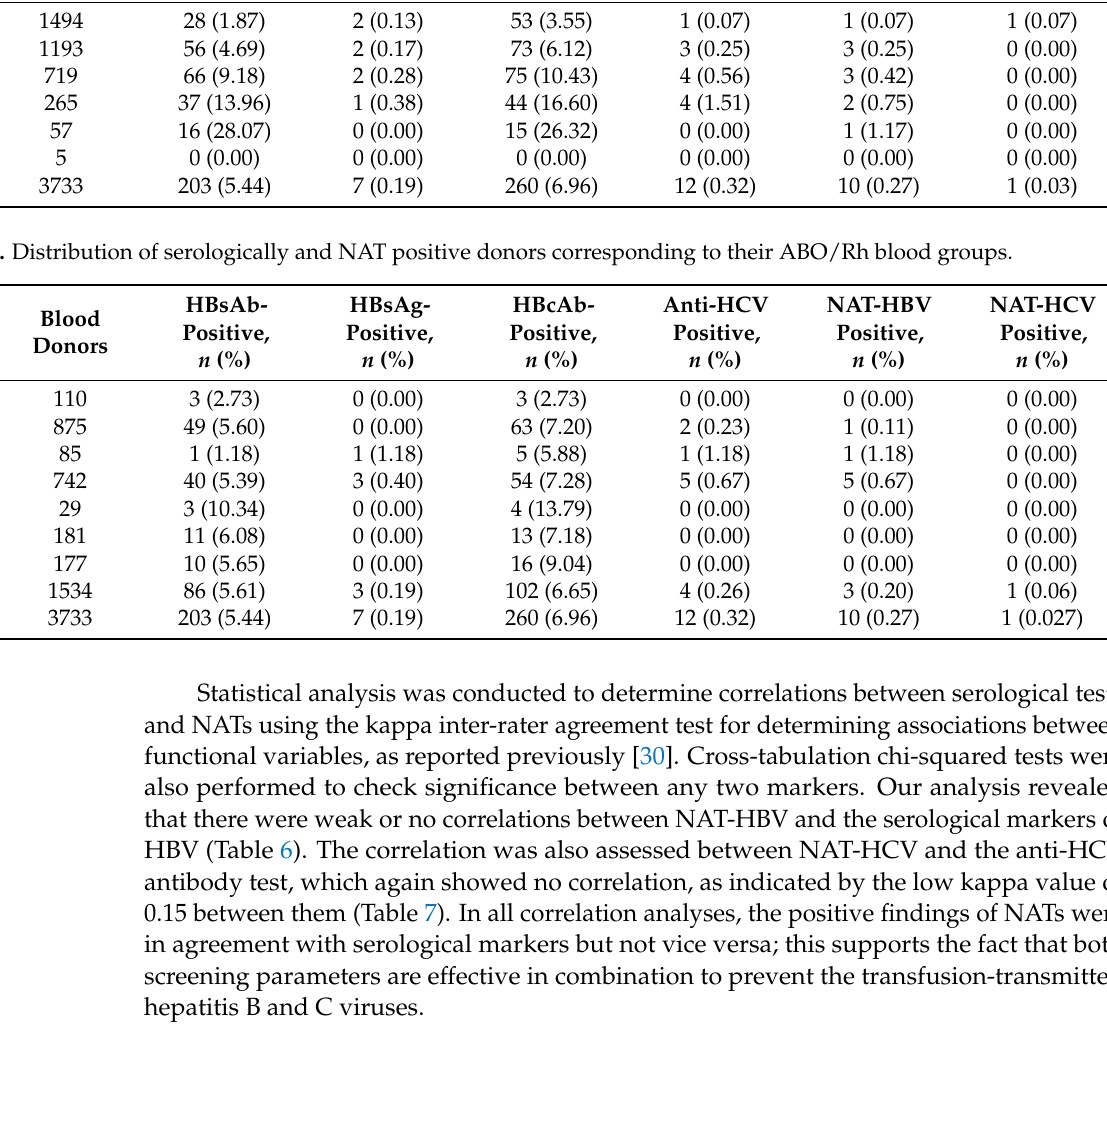
Table 4. Distribution of serologically or NAT-positive donors among different age groups. Age Groups